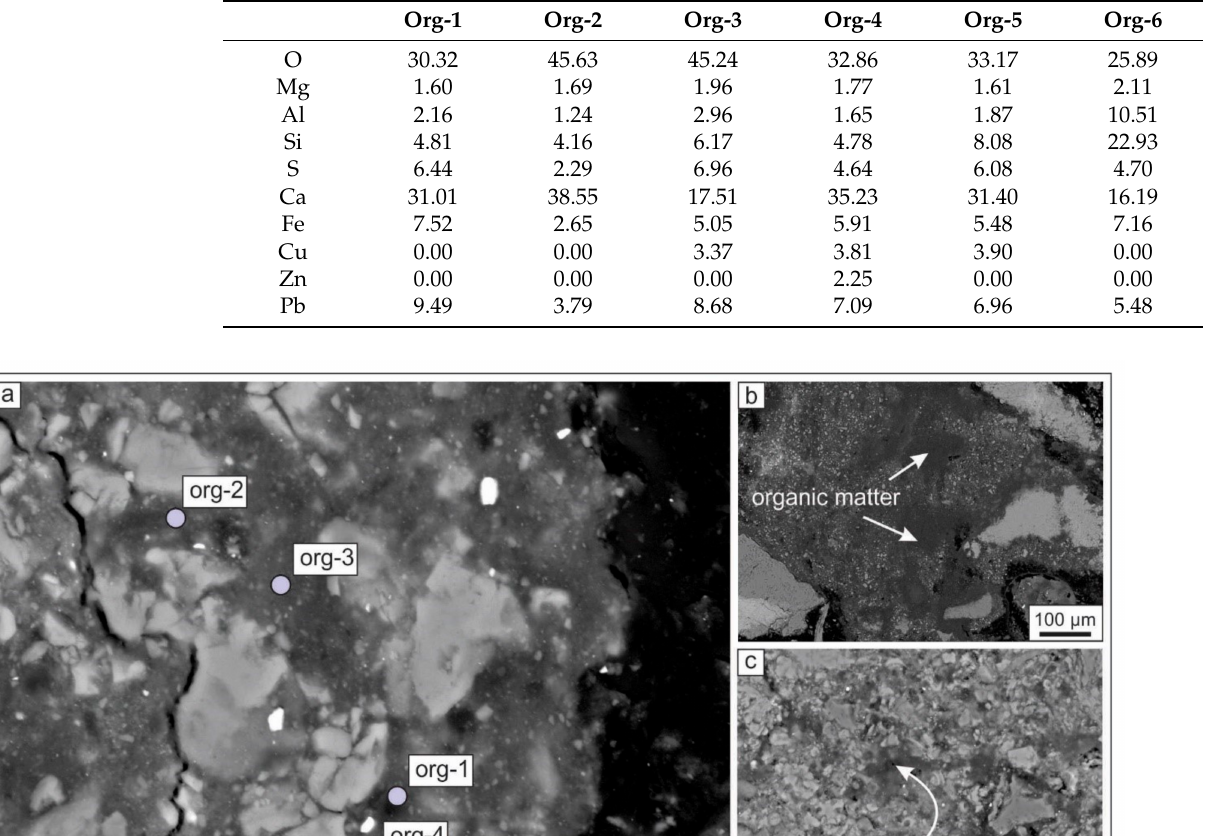
Table 8. Elemental composition of the organic matter-clay mineral mixture. The data are in wt.%.